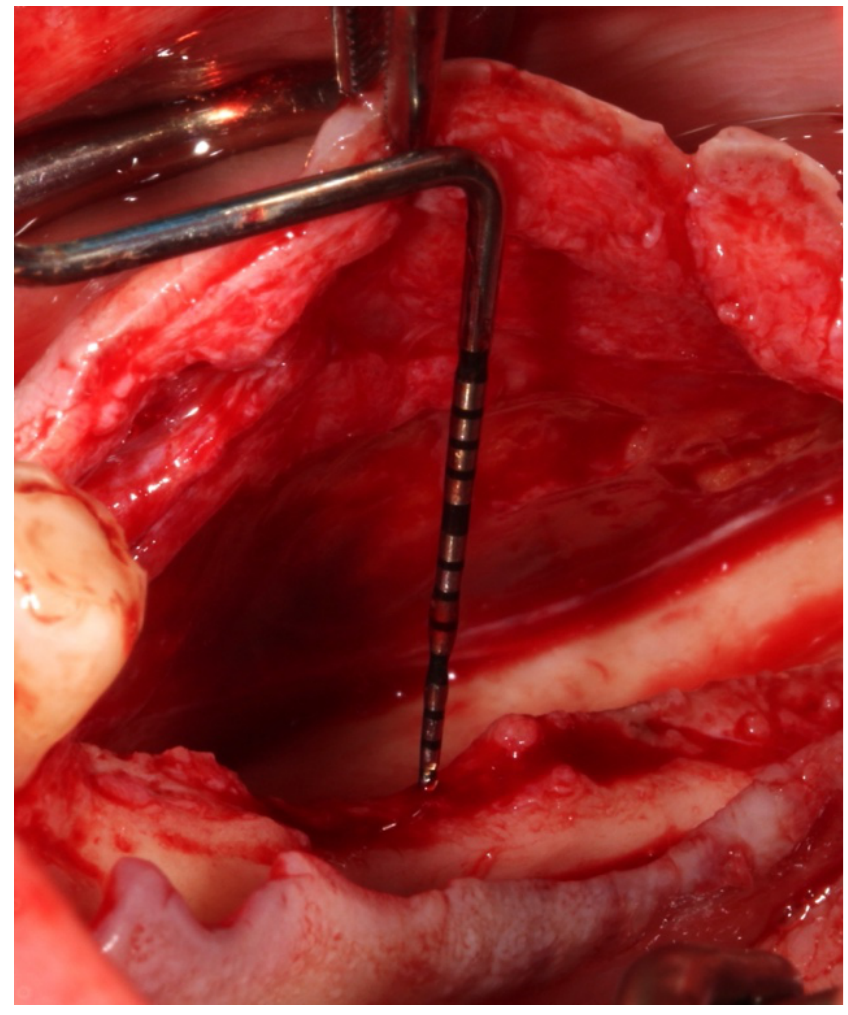
Figure 1. Twenty-three (23) mm of buccal periosteal release in a vertical direction. The mylohyoid muscle or the diaphragma oris muscle is a flat and triangular